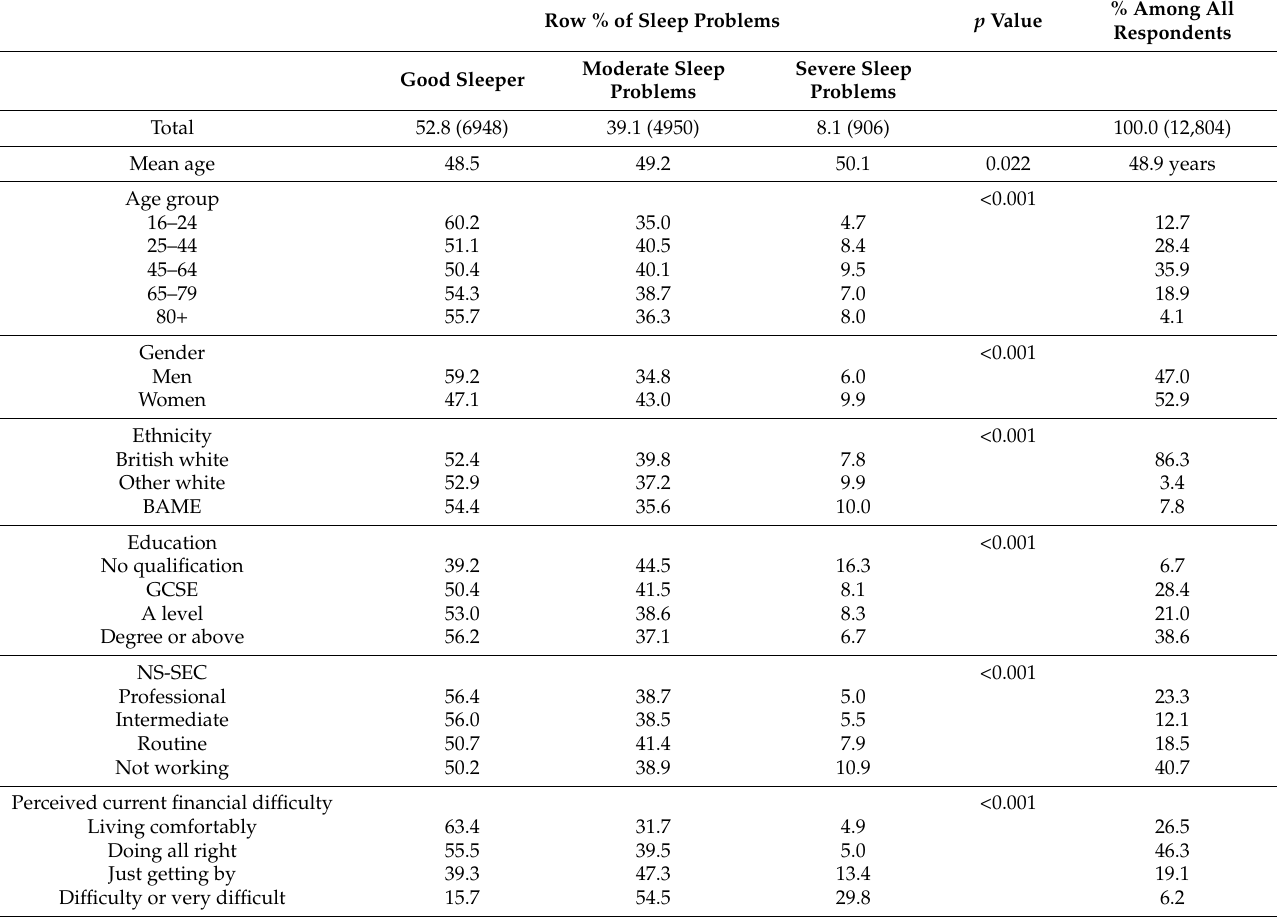
Table 1. Characteristics of the sample and bivariate association between characteristics and the level of sleep problems. Row % of Sleep Problems p Value